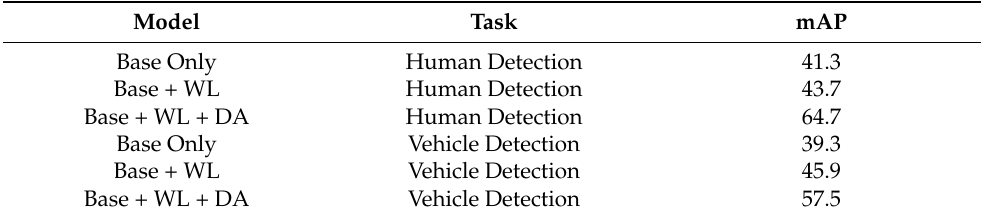
Table 5. Ablation test results of the proposed model. WL denotes usage of Wasserstein loss, and DA denotes usage of domain